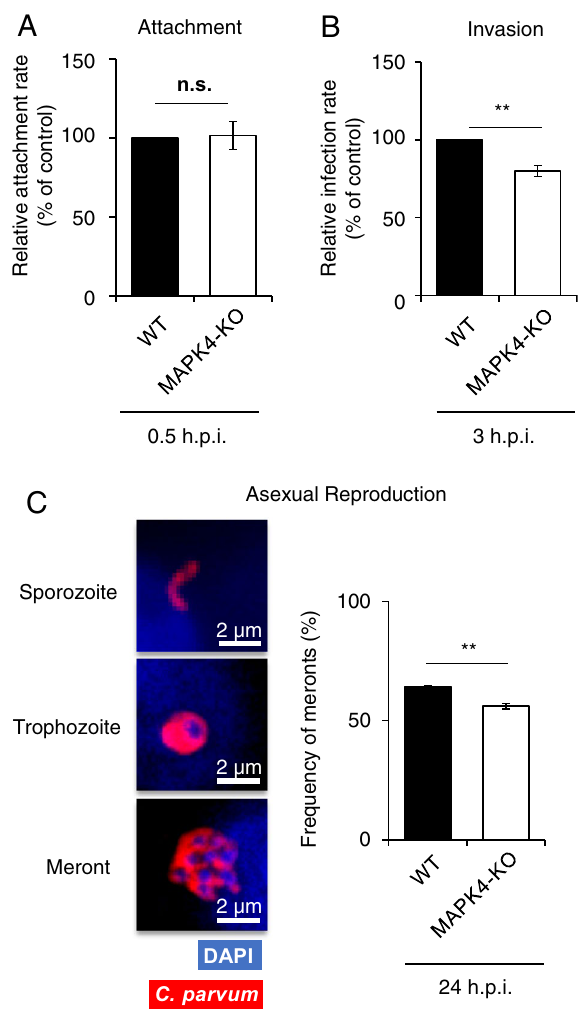
Figure 4. Inhibitory effects on the invasion and asexual reproduction stages of C. parvum in infected MAPK4-KO HCT-8 cells. ( A ) Effect of host MAPK4 deficiency during the attachment. Pre-fixed HCT-8 cells were inoculated with C. parvum sporozoites. The attachment rates were analyzed by use of an immunofluorescence assay at 30 min post-infection. The attachment rates are shown as the ratio of C. parvum - attached host cells amongst total host cells and normalized to the WT HCT-8 cells control . No significant difference was observed (Student’s t test, p = 0.4495). ( B ) Effect of host MAPK4 deficiency on invasion. The infection rate was analyzed 3 h post-infection by means of immunofluorescence assay. The invasion rates are shown as the ratio of C. parvum -infected host cells amongst total host cells and normalized to the WT